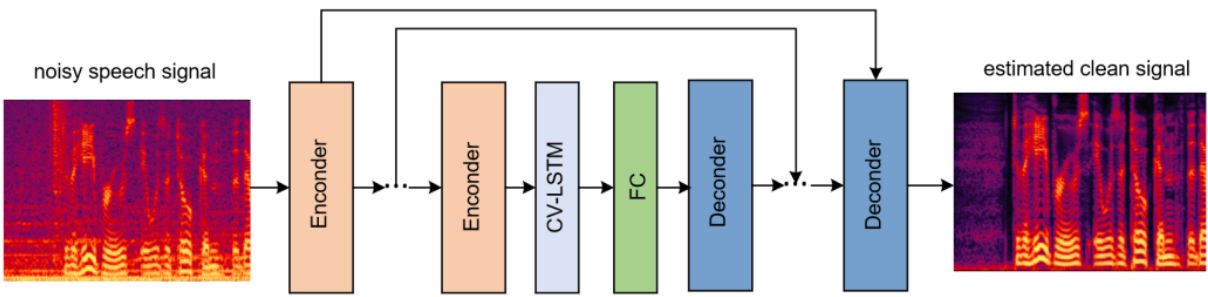
Figure 4. The structure of CV-CNN-LSTM model for speech enhancement.